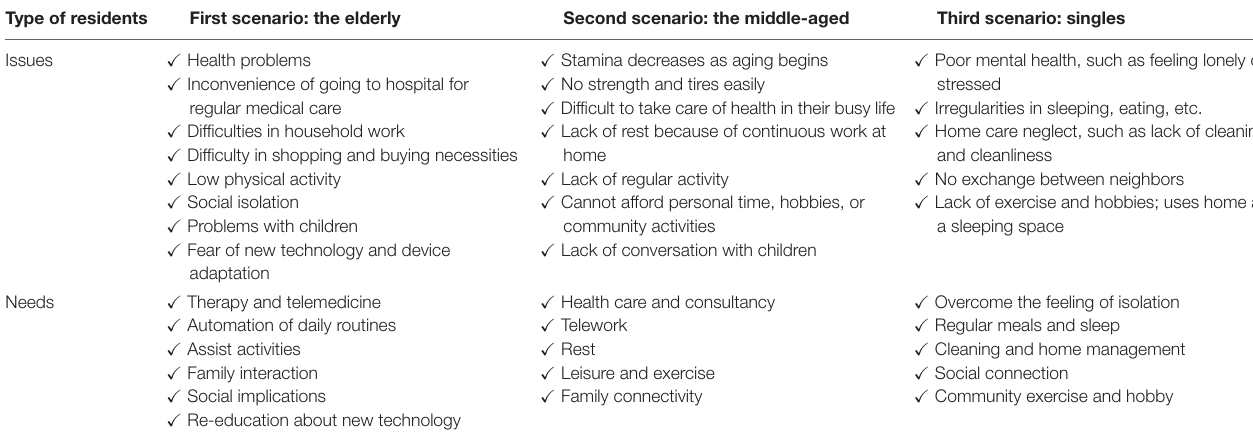
TABLE 2 | Scenario